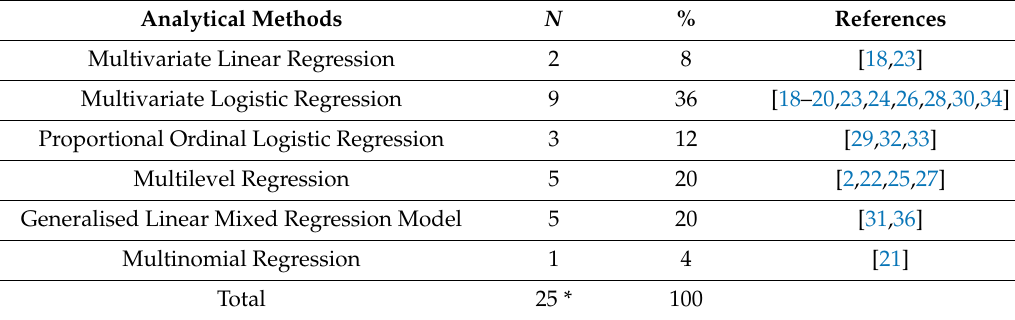
Table 4. Classification of the analytical